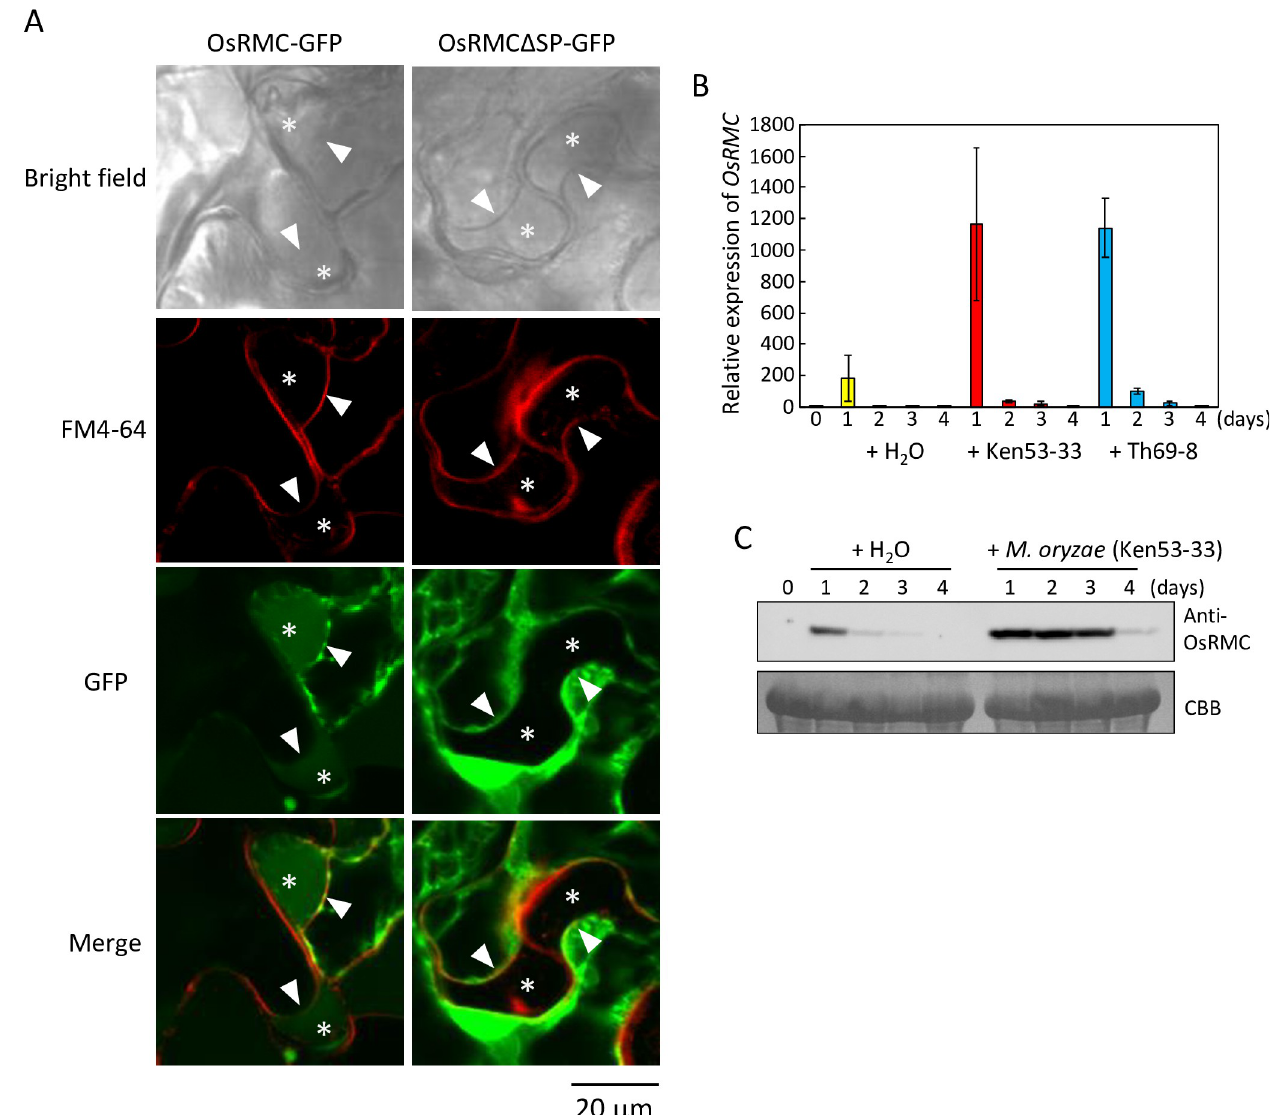
Fig 3. OsRMC is localized to apoplast and the gene expression is induced by M . oryzae infection. (A) OsRMC is localized to apoplast. Subcellular localization of OsRMC was determined using plasmolyzed leaves of N . benthamiana overexpressing OsRMC-GFP or OsRMC Δ SP-GFP by confocal laser scanning microscopy. The cells were also stained with FM4-64 to label the plasma membrane. Asterisk indicates the generated apoplastic space in the plasmolyzed cells. Arrow head indicates the position of plasma membrane. Bars, 20 μ m. (B) OsRMC expression induced by M . oryzae infection in both compatible and incompatible interactions. Expression levels of OsRMC transcripts in rice (‘Hitomebore’) leaves after inoculation with M . oryzae (Ken53-33, compatible strain; TH69-8, incompatible strain, 3.0 X 10 5 conidia each) were determined by qRT-PCR. OsRMC expression level was normalized using that of the rice ubiquitin gene ( LOC_Os03g03920 . 1 ). Data are means ± SD of three independent determinations. (C) OsRMC protein expression is induced after M . oryzae infection. Protein extracts (20 mg) from rice leaves 0–4 days after M . oryzae (Ken53-33) inoculation were subjected to immunoblot analysis using an anti-OsRMC antibody. Equal protein loading on SDS-PAGE was verified by Coomassie Brilliant Blue (CBB)